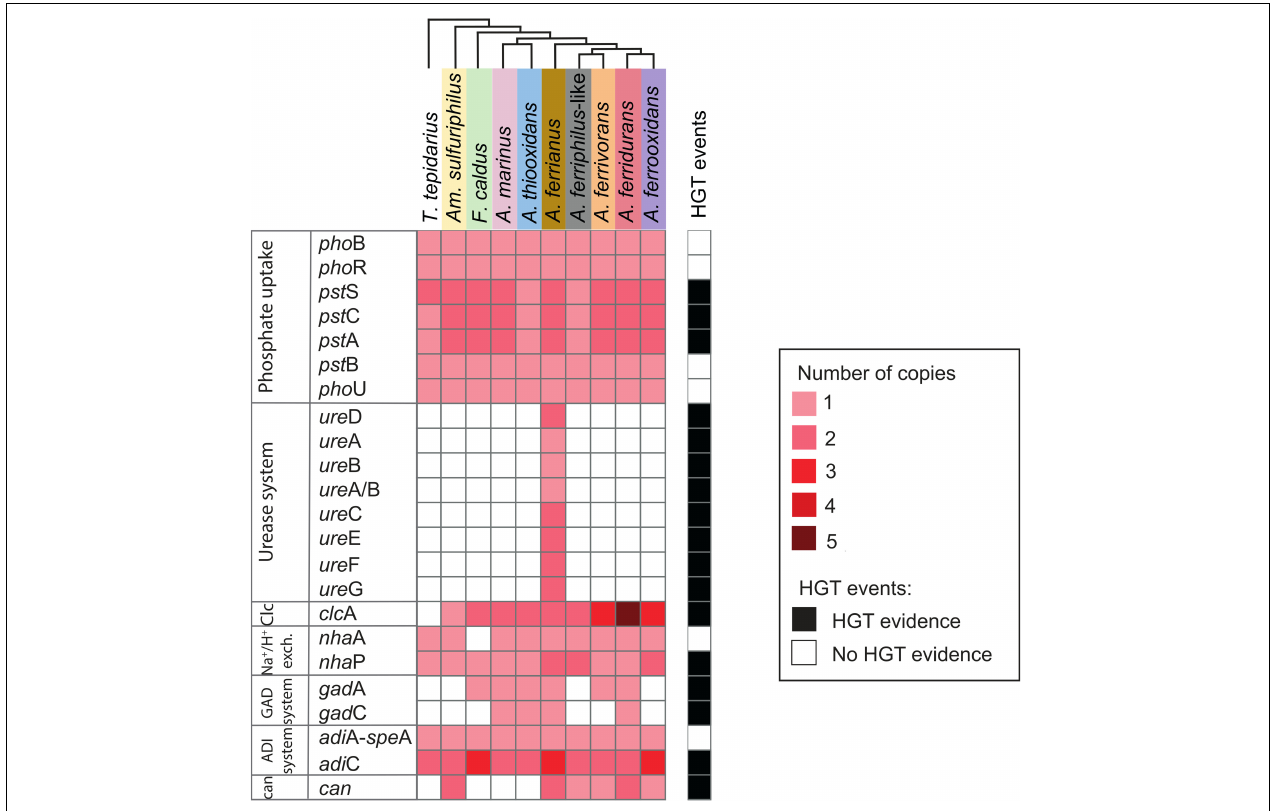
FIGURE 7 | Heatmap of presence (red) and absence (white) of genes involved in second line of defense acid resistance in the Acidithiobacillia class. The red color intensity represents gene copy number per genome. The presence of genes (black; right-hand side) denotes HGT events by genome context with mobile genetic elements, phylogenetic trees, or if it was signaled as part of HGT event by HGTector (Zhu et al., 2014). Species abbreviations are as described in the Figure 3 legend. Second line of acid resistance genes include phosphate uptake, urease system, ClcA antiporter (Clc), proton antiporter (Na + /H + exch.), amino acid decarboxylation (GAD and ADI systems), and carbonic anhydrase (can) (shaded colors correspond to those used in Figure 1 ).